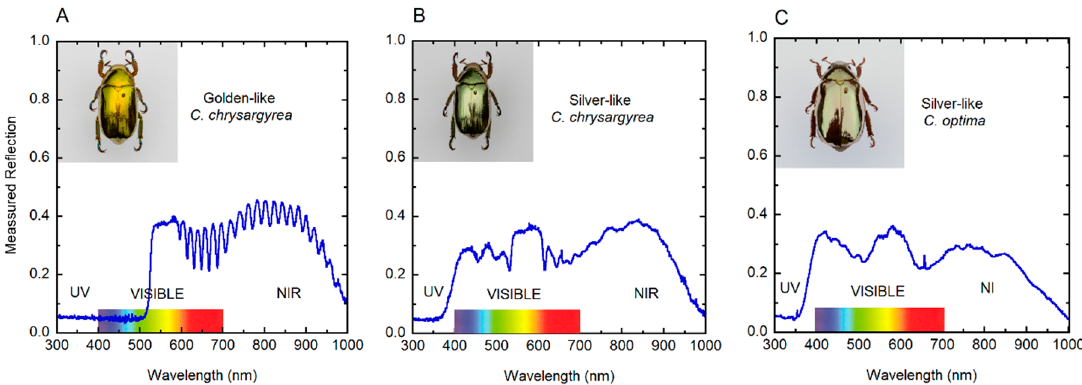
Figure 2. Measured reflection spectra of elytra from ( A ) golden-like C. chrysargyrea , ( B ) silver-like C. chrysargyrea , and ( C ) silver-like C. optima scarabs illuminated with normally incident non-polarized light. NIR: Near infrared; UV: Ultraviolet.